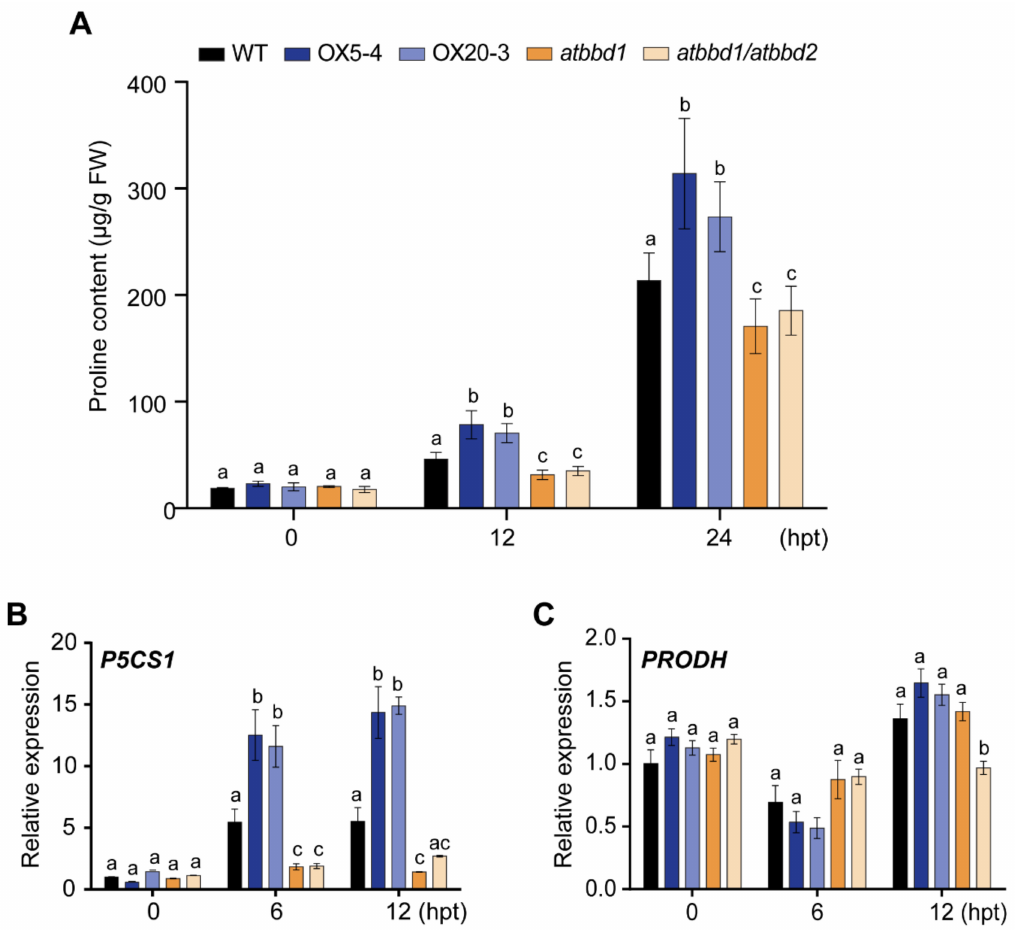
Figure 4. Analysis of proline in the WT, two BBD1 -Ox lines, atbbd1, and atbbd1/atbbd2 plants under drought stress conditions. ( A ) Free proline contents were measured at designated time points from the leaves of three-week-old soil-grown plants stressed by watering with 20% PEG 6000. ( B ) The expression of the proline biosynthesis gene P5CS1 was analyzed by qRT-PCR. ( C ) The expression of the proline catabolic gene PRODH was analyzed with qRT-PCR. The RNA was isolated at designated time points from three-week-old soil-grown plants stressed by watering with 20% PEG 6000. The relative gene expression was calculated and normalized to the reference gene eIF4a1 . The normalized mRNA levels at 0 h were set to 1. Data represent the mean ± standard error values of three independent experiments. One-way ANOVA with post-hoc Tukey test was used for the statistical comparison of all genotypes. Different letters indicate significant differences among genotypes at each time point ( p <